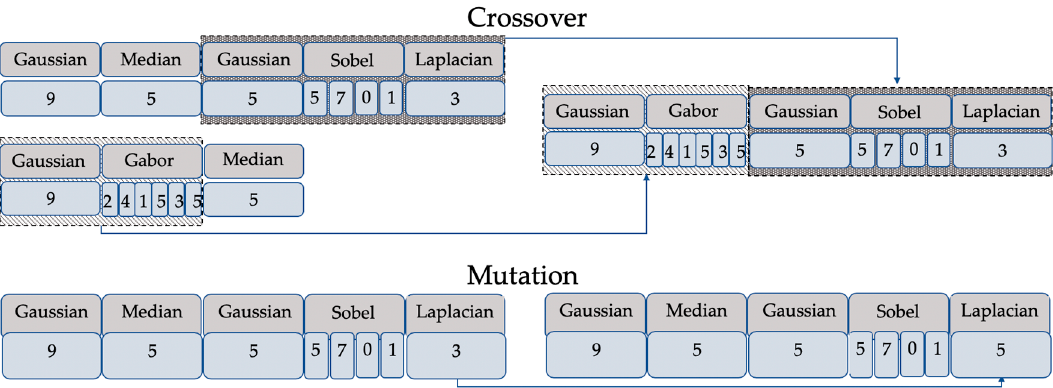
Figure 3. Examples of crossover and mutation.